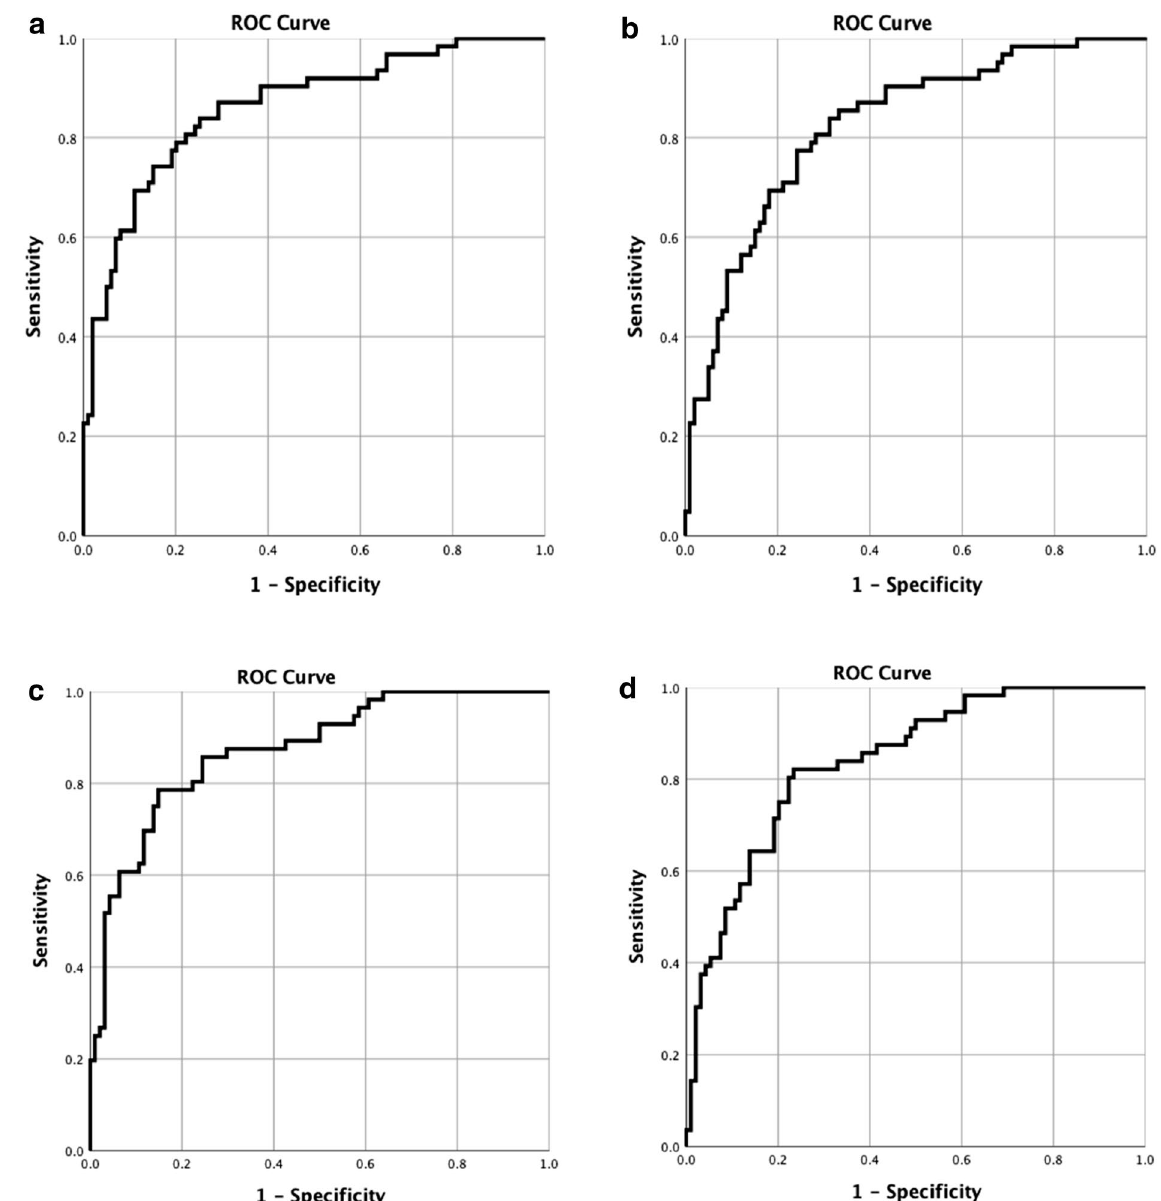
Figure 4. ( a ) ROC-curve with a combination of hepcidin and CRP at admission after performing logistic regression. AUC 0.861. ( b ) ROC-curve with a combination of hepcidin and PCT at admission after performing logistic regression. AUC 0.825. ( c ) ROC-curve with a combination of HBP and CRP at admission after performing logistic regression. AUC 0.872. ( d ) ROC-curve with a combination of HBP and PCT at admission after performing logistic regression. AUC